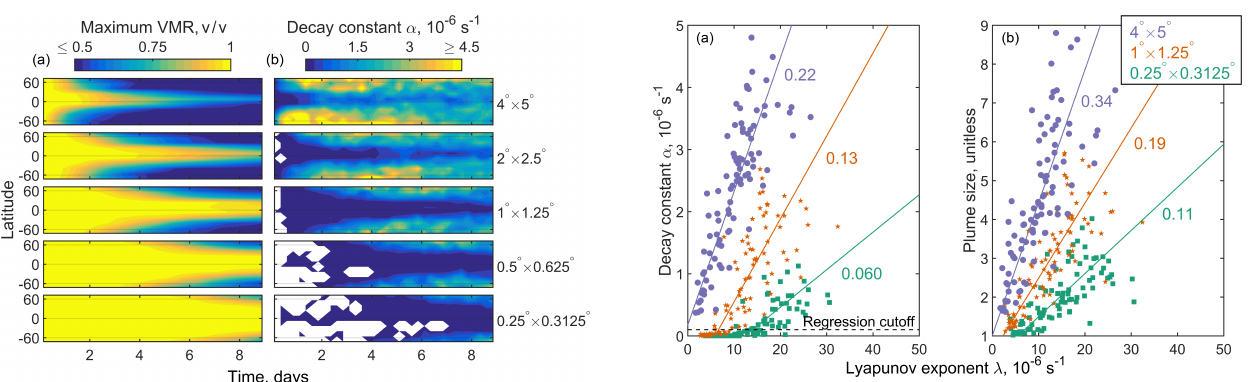
Figure 3. Evolution with time of the maximum VMR and the decay constant α for GEOS-Chem plumes initialized at different latitudes in a 2-D (horizontal) flow. White areas in the right panels corre- spond to no significant plume decay ( α ≈ 0).